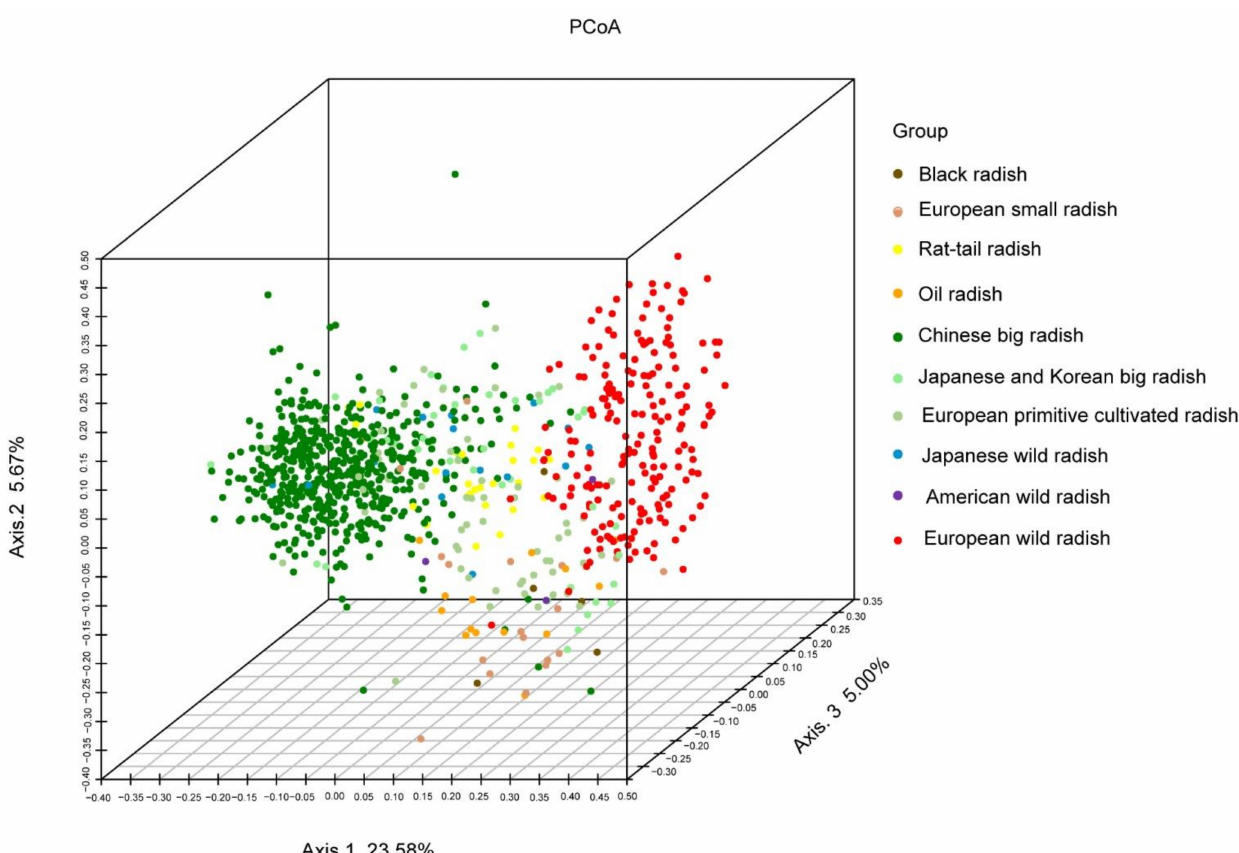
Figure 3. PCoA of 939 radish genotypes based on SSR-Seq with 38 pairs of SSR